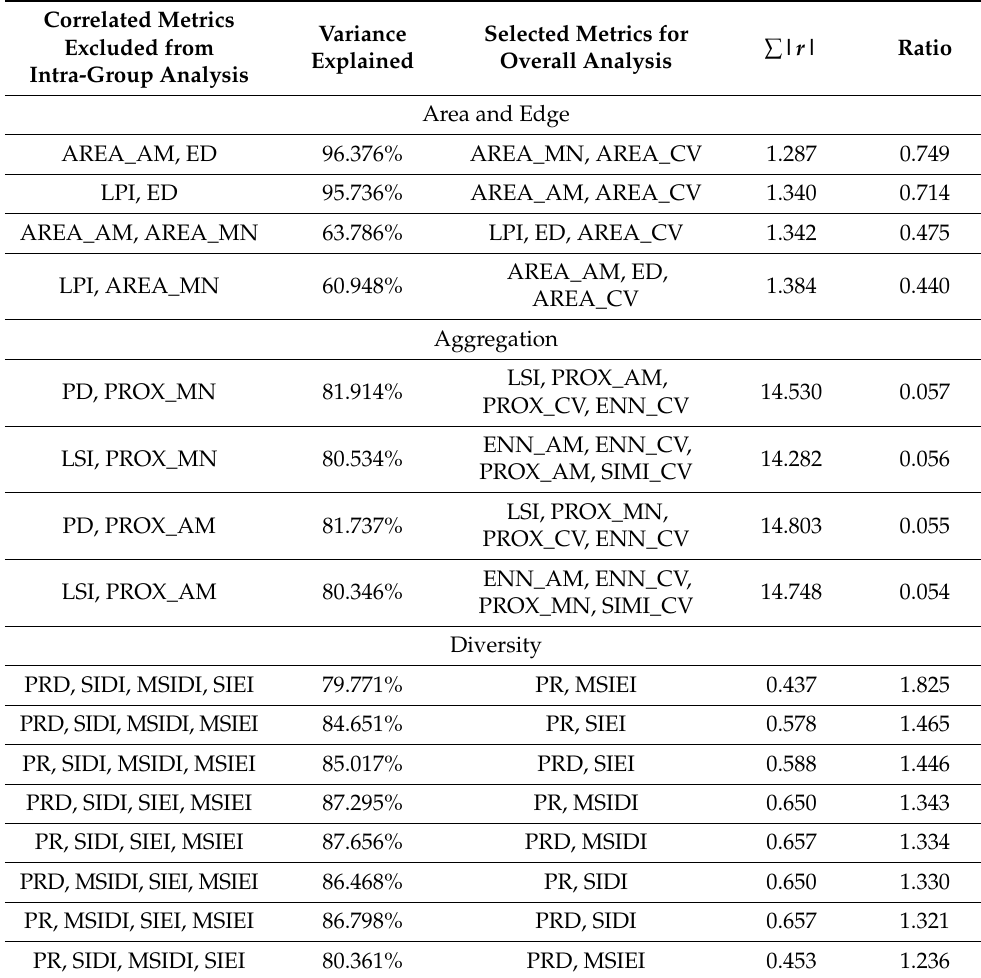
Table 1. Metric selection for Area and Edge , Aggregation , and Diversity